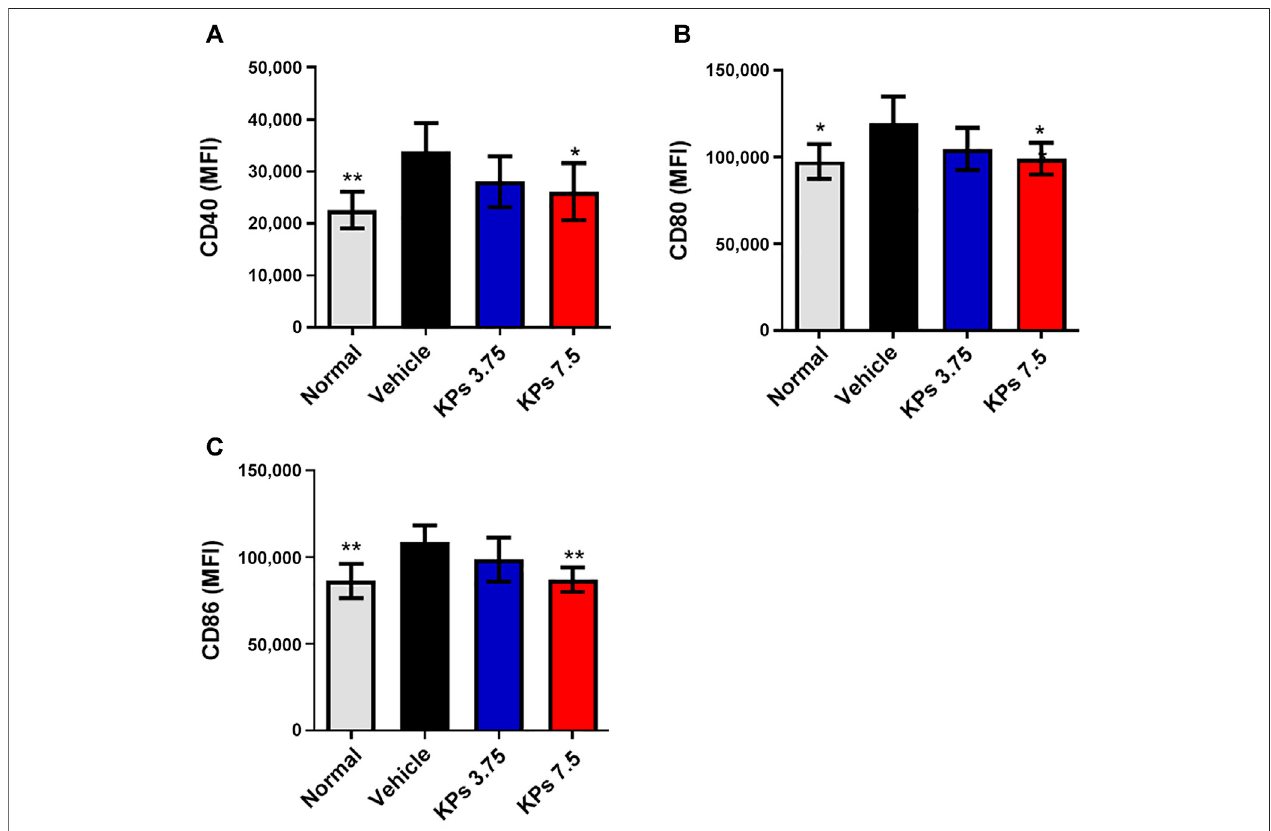
FIGURE 6 | Effect of KPs on splenic DC maturation in mice with CIA. Flow cytometry analysis of cells collected from the spleens of the mice in different groups on day 42 after immunization. MFI of CD40 (A) , CD80 (B) , and CD86 (C) on CD11c + DC cells was examined by fl ow cytometry. Bar graphs show the quanti fi ed data from threeindependentexperiments. Thevaluesarepresented asthemean ± SEM(n (cid:1) 5).* p < 0.05; ** p < 0.01;*** p < 0.001vstheCIA/vehiclecontrolgroup,asdetermined by one-way ANOVA with Dunnett ’ s test.